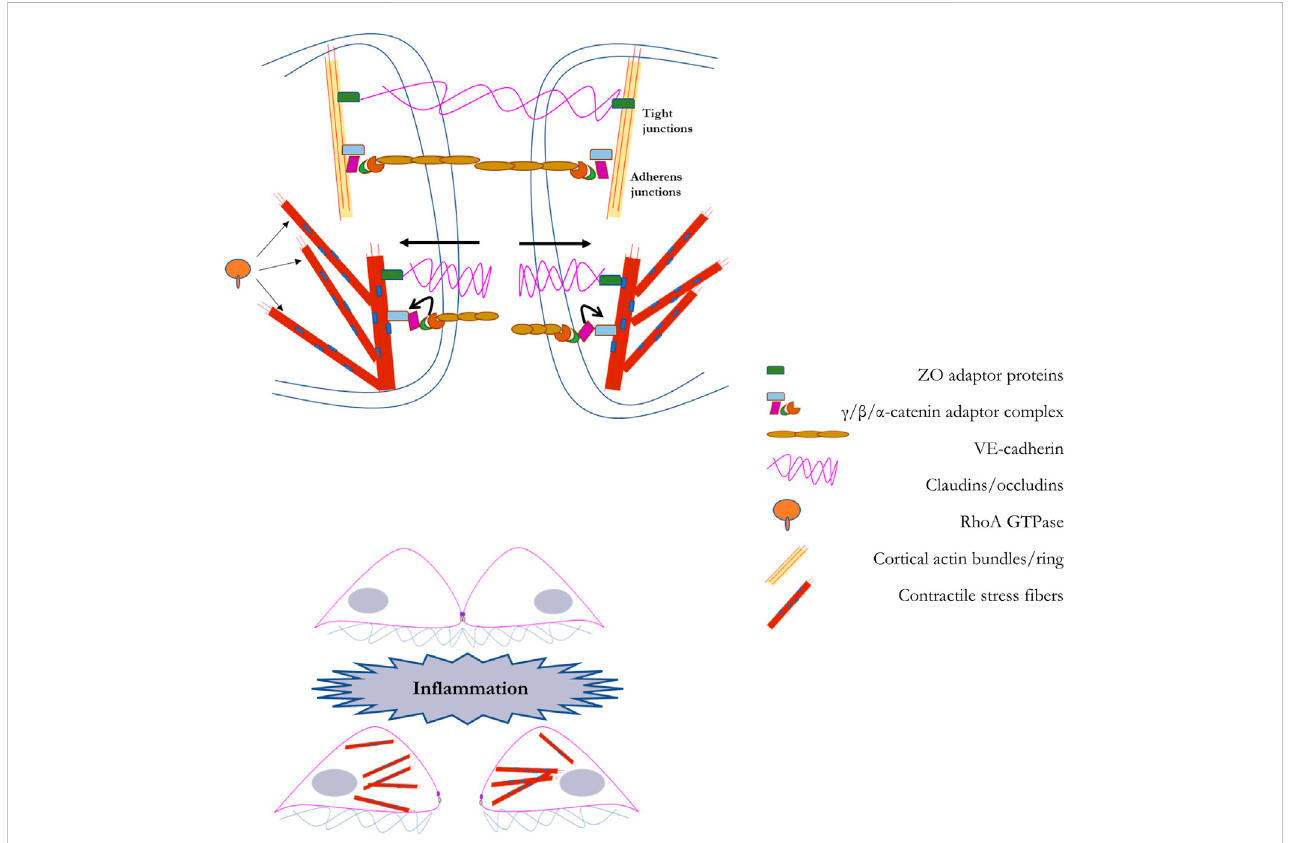
Aschematicrepresentationoftheregulationoftheendothelialbarrierbythemechanicalpropertiesofendothelialcells:Inthetoppanelweillustratethe barrier that couples adjacent endothelial cells. The endothelialbarrier between adjacentcells provides a method for the controlled passage of molecules into the vascular wall. This barrier is primarily composed of tight junctions (composed of occludens and claudins) and adherens junctions (composed of VE- cadherin and catenins). The endothelial barrier maintains its integrity with scaffolding support from cortical actin fi bers. In the bottom panel we illustrate theprocessthroughwhichbarrierdisruptionisinduced,suchasduringin fl ammation. Via RhoA-dependentgenerationofF-actinstress fi bernetworks,barrier degeneration is accomplished through force-based uncoupling of junctional proteins, leading to their sequestration, and facilitating gap formation between adjacent cells. A detailed explanation into the role of RhoA-dependent F-actin stress fi ber networks in barrier degeneration is provided in Section 6 of the